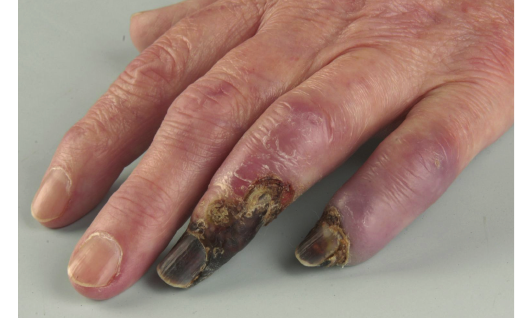
Figure 1: Clinical findings after admission of the patient, 3 days after the injection.